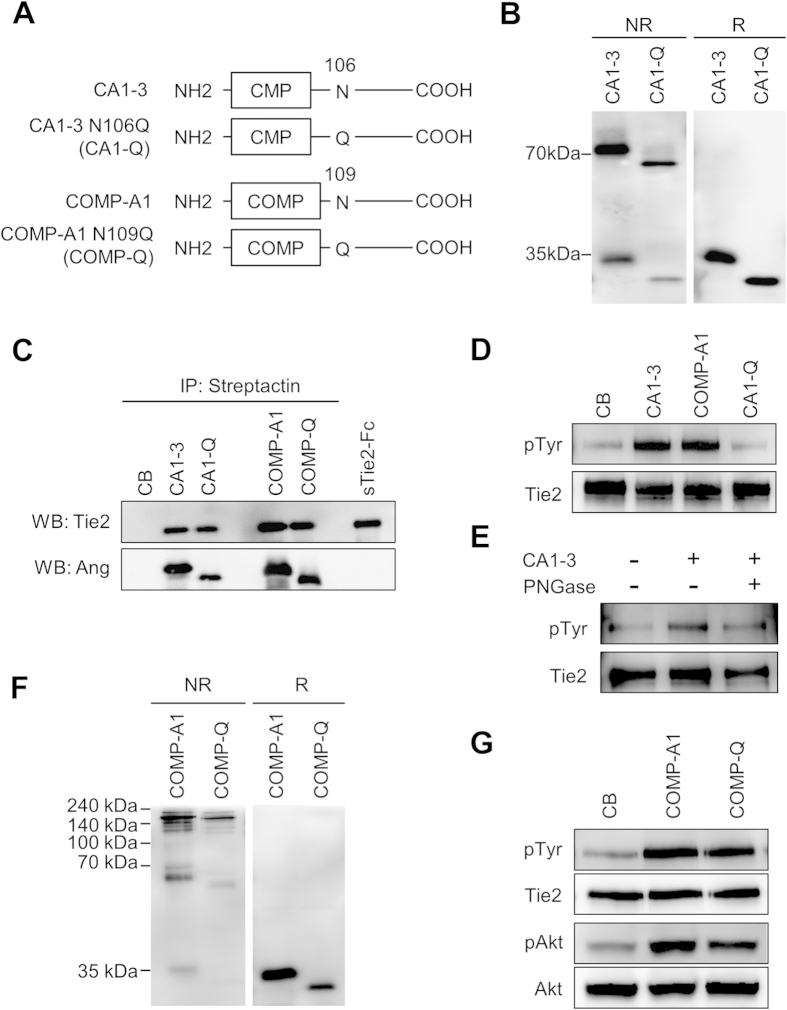
N-glycosylation of dimeric CMP-Ang1 is critical for protein activity.(A) Schematic diagram of N-glycosylation mutants of CA1-3 and COMP-Ang1 (CA1-Q and COMP-Q, respectively). For CA1-Q, the N-glycosylation site, asparagine (N) at 106 residue of CA1-3 is substituted to glutamine (Q) to inhibit N-glycosylation. Similarly, for COMP-Q, the N-glycosylation site at 109 residue of COMP-Ang1 is substituted to glutamine (Q). (B) CA1-3 and CA1-Q were separated by SDS-PAGE under non-reduced (NR) and reduced (R) conditions, and immunoblotted with anti-Ang1 antibody. Molecular masses (kDa) are indicated on the left. (C) In vitro binding assay of CA1-3, CA1-Q, COMP-Ang1, and COMP-Q to Tie2. (D) HUVECs were starved and then stimulated with 500 ng/ml of indicated proteins for 15 min and the phosphorylation of Tie2 was detected by immunoprecipitation and immunoblotting. (E) Tie2 phosphorylation after treatment with either control buffer, CA1-3, or CA1-3 and PNGase F. (F) SDS-PAGE analysis of COMP-Ang1 and COMP-Q. (G) Tie2 and Akt phosphorylation activity of COMP-Ang1 and COMP-Q.